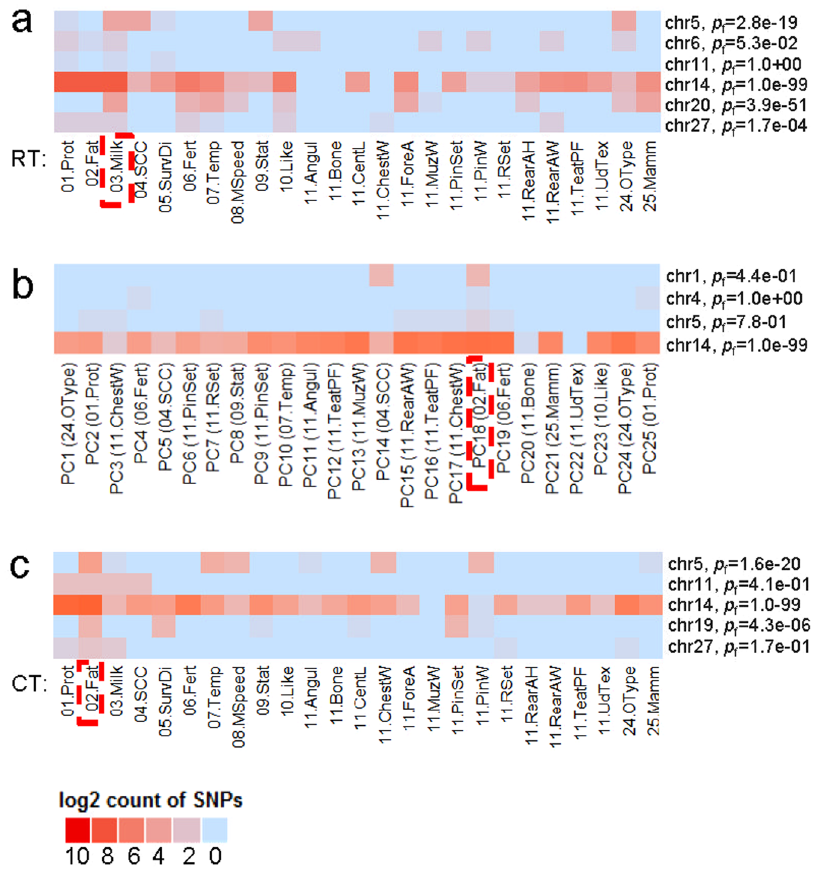
Figure 2. The breakdown of shared significant SNPs detected for selected traits with the other traits on each chromosome. As highlighted in red dashed boxes, selected milk yield raw trait ( a ), principal component 18 ( b ) and Cholesky transformed fat yield ( c ) had the largest numbers of significant ( p s ) SNPs detected by single-trait GWAS for RT, PC and CT, respectively (Table 1). The number of shared SNPs for the each other trait (non- selected) were determined at the p s < 0.05 level (see methods). Significances of the enrichment of chromosomes containing the amount of significant SNPs detected for selected traits were based on the Fisher’s exact test ( p f ). The RT associated with the top factor loading value of each PC was shown in the parentheses (Supplementary Table